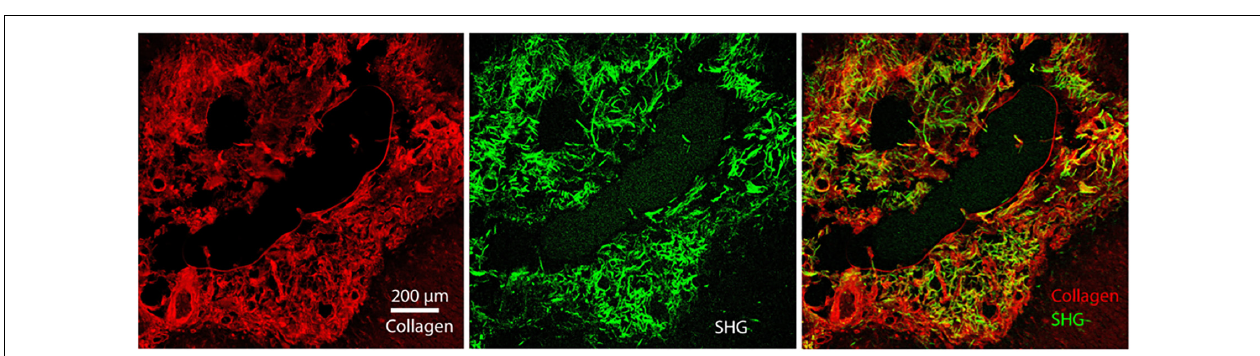
FIGURE 4 | Horizontal slices through implanted probes show collagen deposition. SHG imaging (green, 890 nm excitation 445/40 nm emission) shows collagen fibers around neural probes, independent of the indwelling device material. Multiple slices through the same polyimide device show that the collagen fibers are most abundant close to the cortical surface (Ai) but are still observable in deeper cortical regions (Aii) Collagen fibers were also observed on and around neural probes made of OSTE soft (B) and OSTE hard (C) materials. Autofluorescence from the implanted device is shown in gray (890 nm excitation, both 445/40 and 592/100 nm emission). Scale bar = 50 microns.